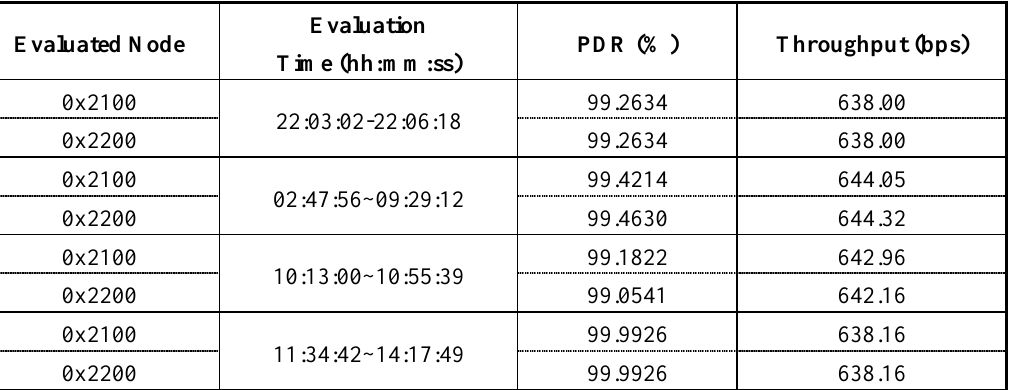
Table 4. End-to-End packet delivery